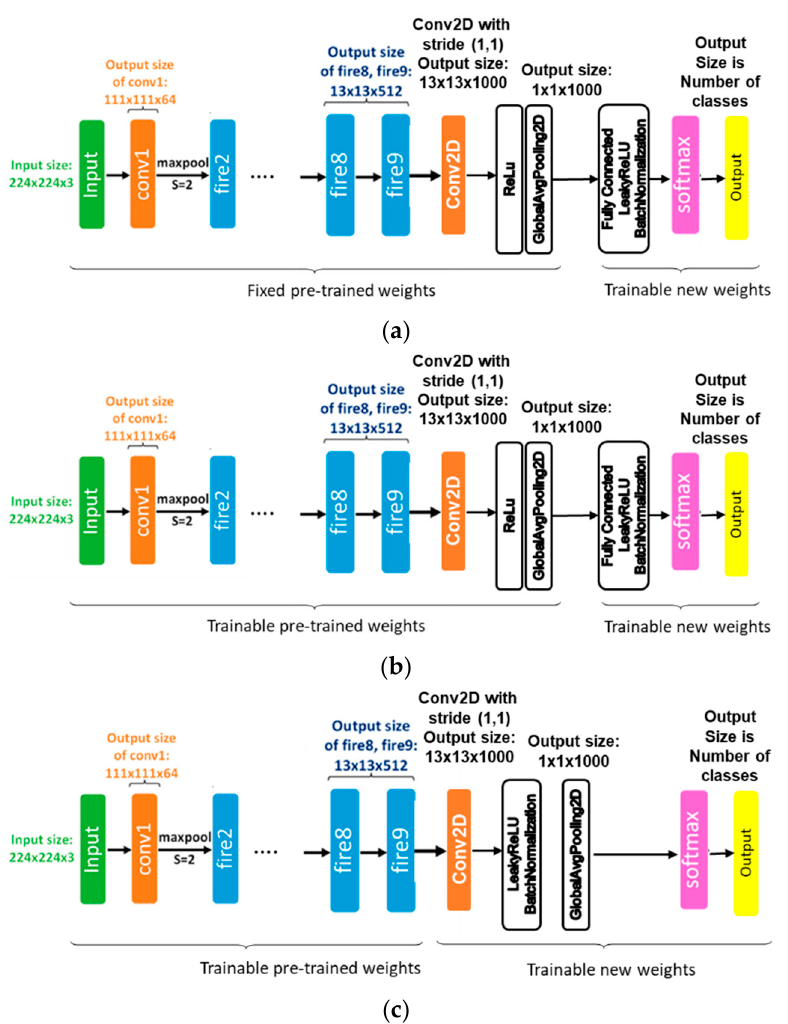
Figure 5. Proposed architecture using the SqueezeNet pre-trained model. (a) Model 1: base model with fixed pre-trained SqueezeNet. (b) Model 2: fine-tuned Model 1. (c) Model 3: fine-tuned SqueezeNet with new random weights for the last convolutional layer (after fire9).